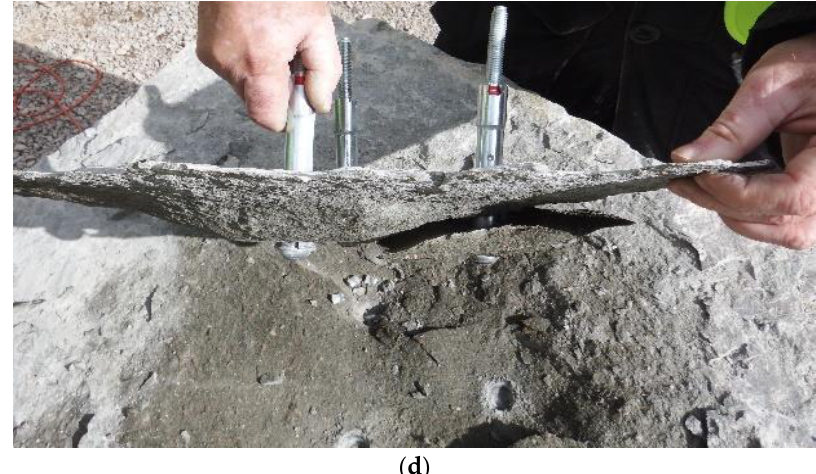
Figure 14. Break-out prisms—the 3-anchor group: ( a ) fractured rock material, ( b ) failure surface, ( c )–( d ) group effect in rock cone failure (a group of 3 anchors).